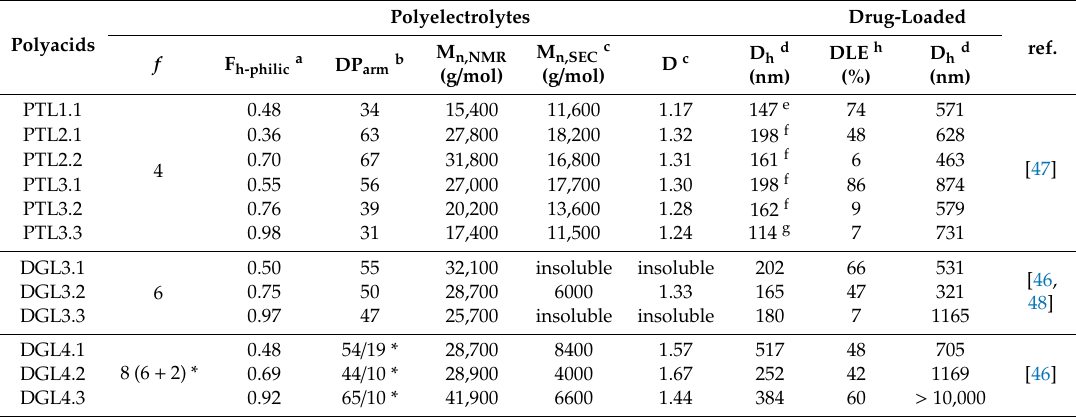
Table 3. Characterization of star-shaped polyacids used for drug encapsulation (DDS type III).